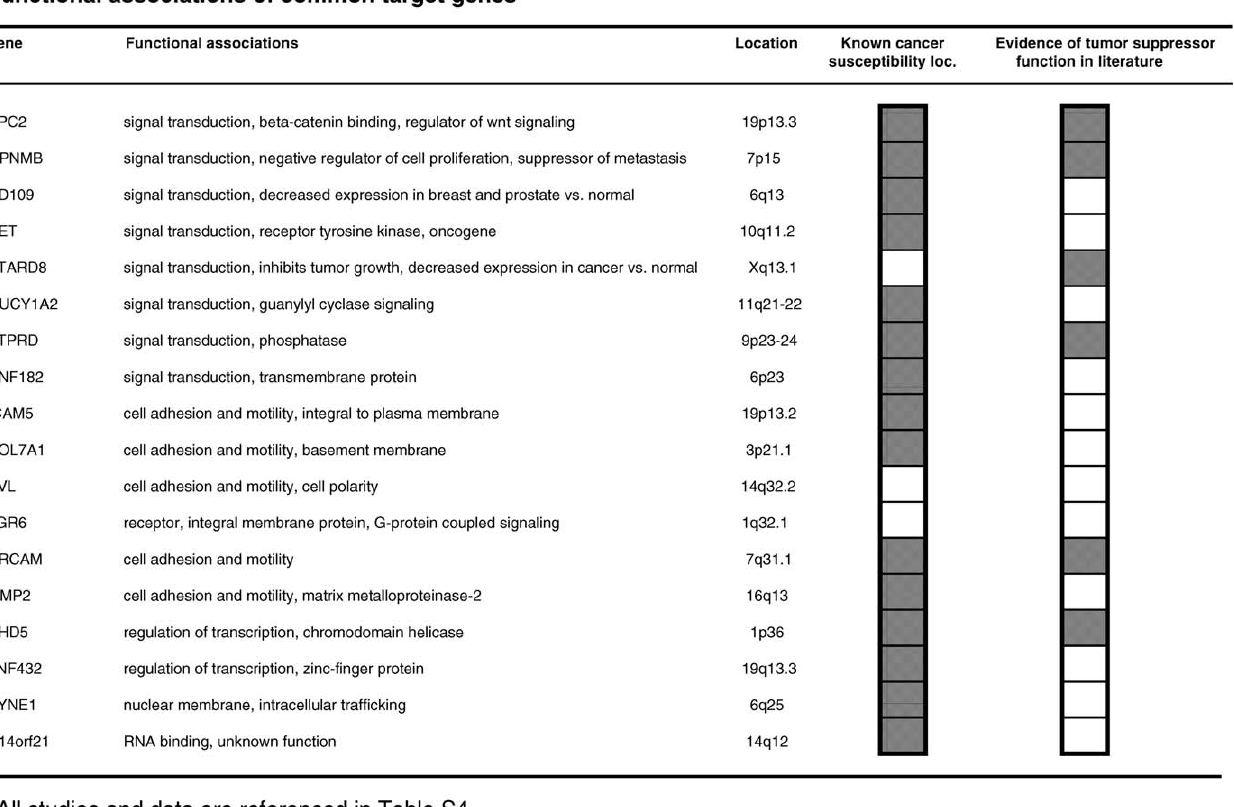
Figure 8. Functional Associations of Common Target Genes Functional associations of genes were determined using Gene Ontology (GO) groups and available literature. Evidence for tumor suppressor function was scored positive if reports in the literature show that the gene of interest can suppress growth of cancer cells in vitro, in vivo, or in murine genetic models, or modulate known tumor suppressor function. loc., location. Known cancer susceptibility location was scored positive if evidence exists in the literature for LOH or homozygous deletion in primary human tumors at the region shown using either standard genetic mapping or comparative genomic hybridization (CGH) analysis (shaded).